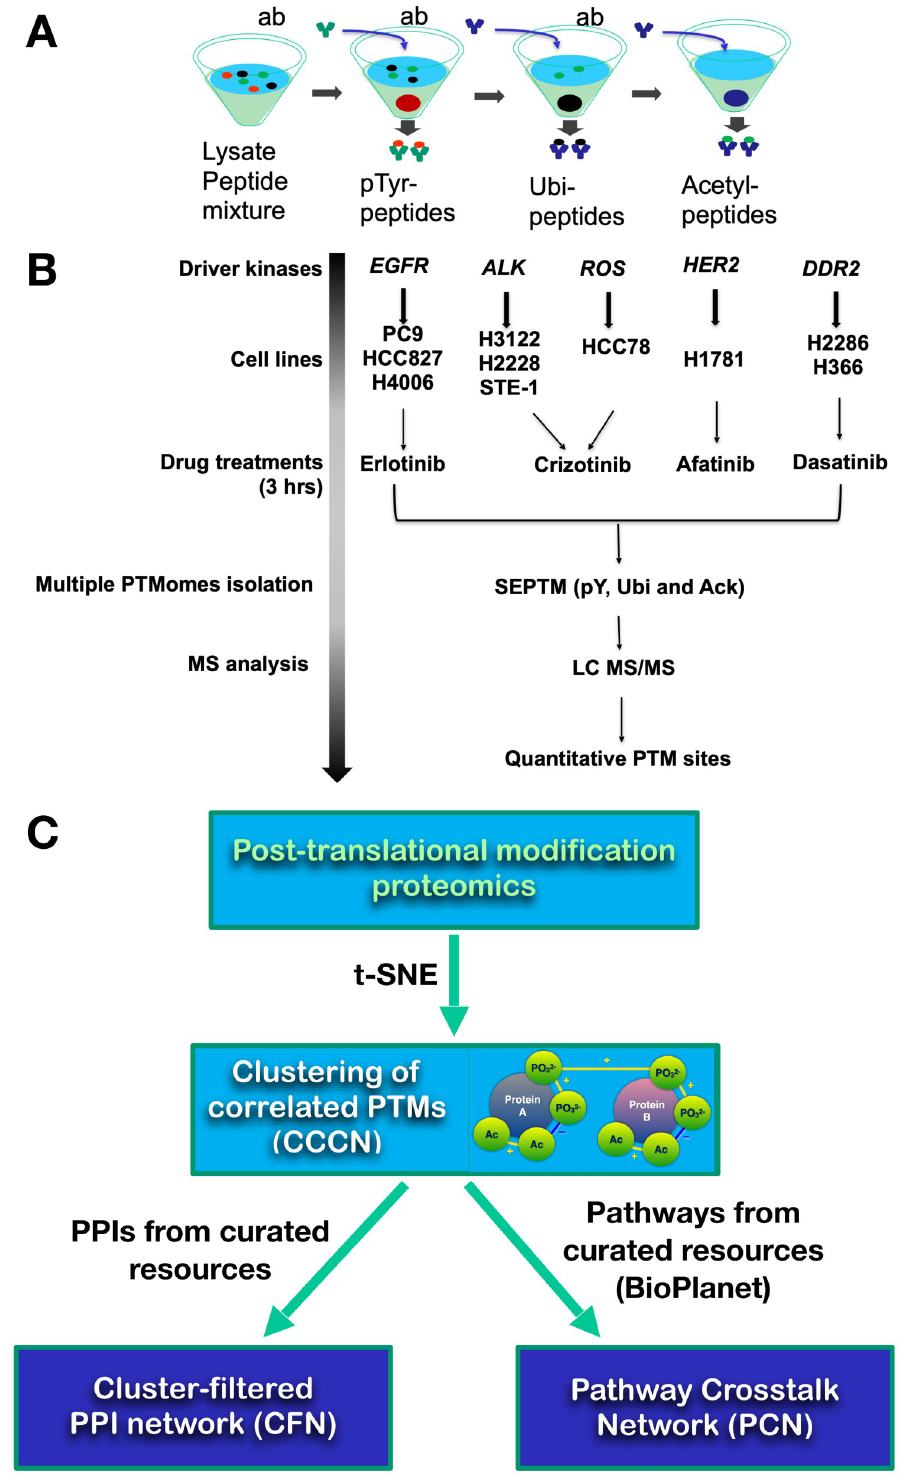
Fig 1. Strategy. Sequential enrichment of post translational modification proteomics (SEPTM-proteomics) procedure. (A) Principle of SEPTM peptide enrichment; modification-specific antibodies pull down specific PTMs sequentially. (B) Proteomics data generation procedure and drug-cell line combinations analyzed. (C) Graphical outline